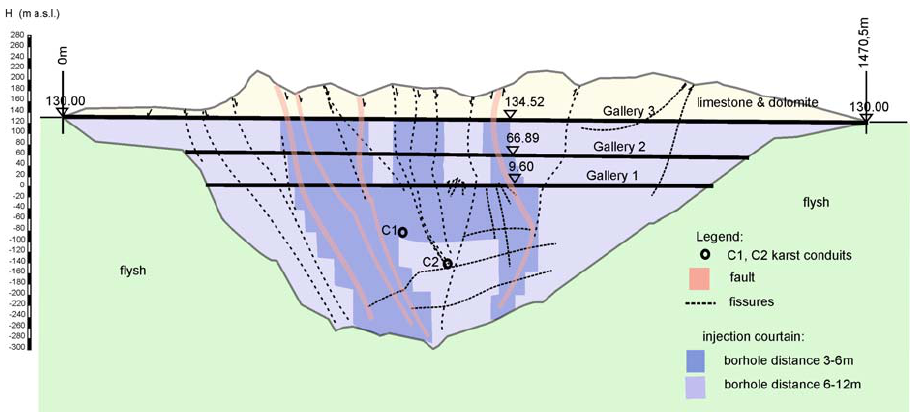
Fig. 4. Cross-section through the projected grout curtain (underground dam) (modified after Ravnik and Rajver, 1998; Sever, 2003). Figure 4